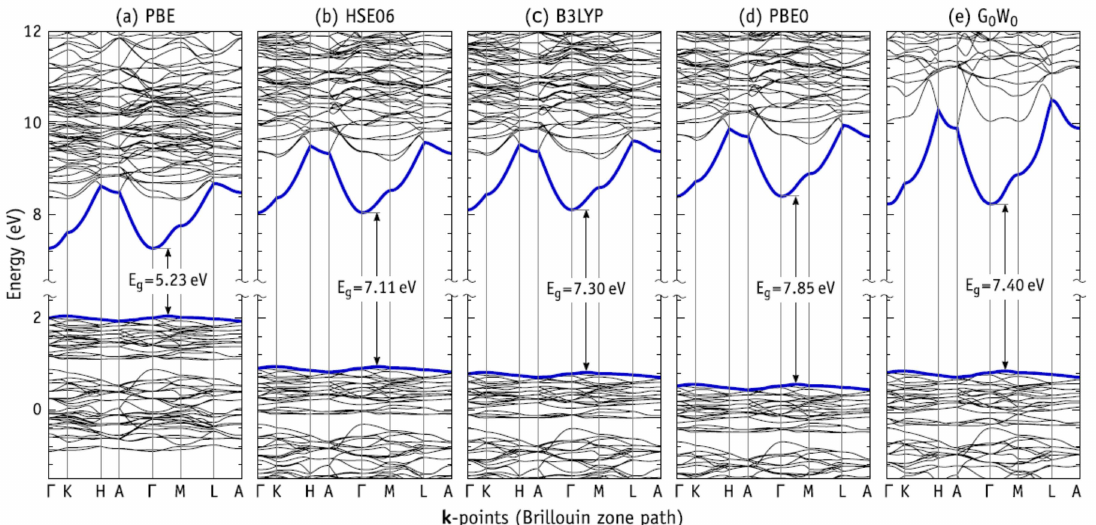
Figure 5. Electronic band structure of bulk perfect stoichiometric hydroxyapatite along a path with breaks at k-points of high symmetry. The calculations were carried out using DFT using functionals: ( a ) PBE—in the generalized gradient approximation (GGA), and hybrid functionals: ( b ) HSE, ( c ) B3LYP, and ( d ) PBE0, as well as ( e ) using the method multi- particle perturbations G0W0 using the wave functions of the PBE functional. The maximum valence and minimum conduction bands are shown in bold lines. Indirect transitions determining the band gap Eg are also shown for each case. (Adapted with permission from [7]; AIP Publishing,